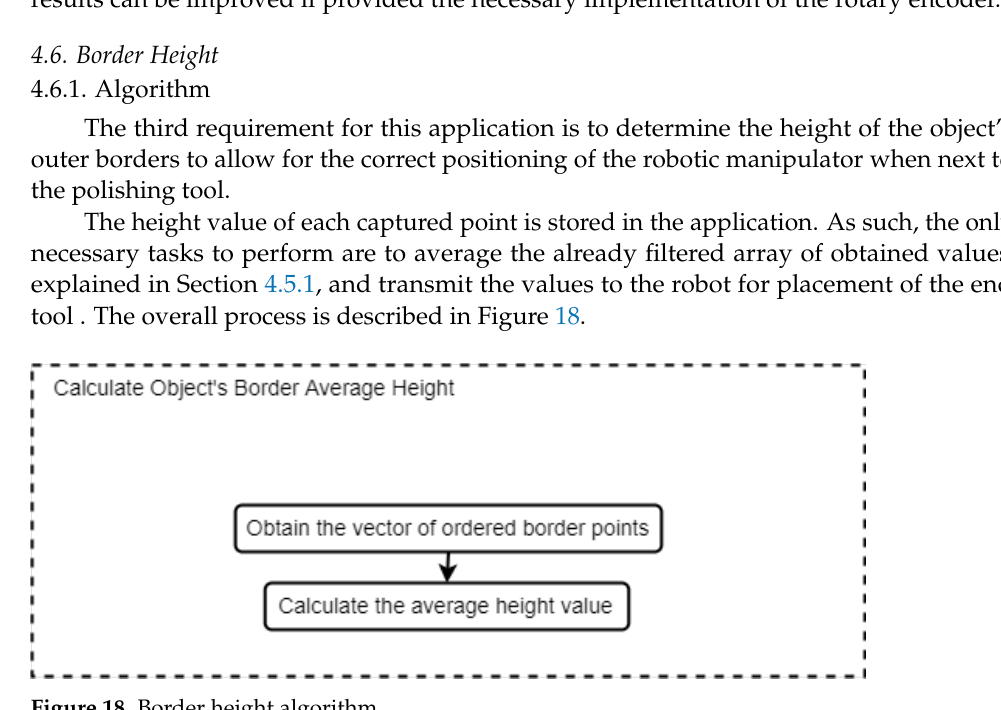
Figure 18. Border height